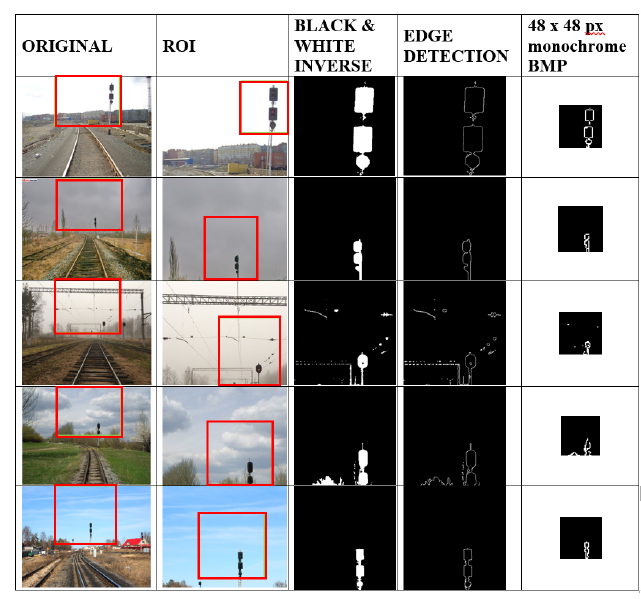
Fig. 10. Training set of traffic light recognition.